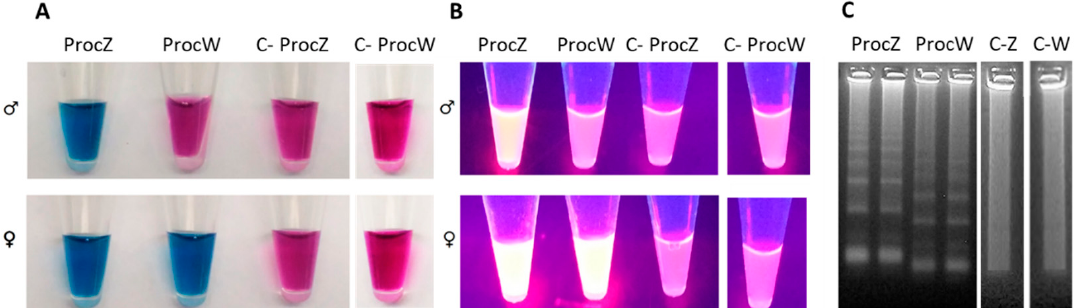
Figure 5. Visual detection of LAMP products using the set of primers ProcZ-ProcW on C. diomedea . ( A ) Detection using EBT: the color of the reaction with daylight was blue when LAMP reaction was positive and remained red when there was no amplification and in the negative control (C-). ProcZ mix reaction amplified both males and female samples; ProcW mix was specific for female samples. ( B ) Fluorimetric detection using GelRed. The presence of fluorescence is observed in ProcZ mix reaction, specific for males and female samples; no fluorescence signal is observed in male samples amplified with ProcW mix and in the negative control. ( C ) PCR products were observed in agarose gel by electrophoresis analysis. C-Z; C-W) negative control ProcZ and ProcW mix, respectively.